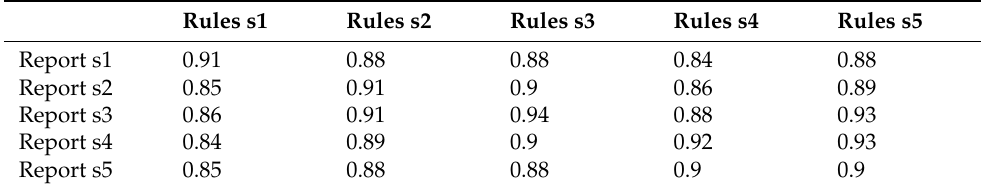
Figure 3. The framework of the experiment for cause identification. Table 9. Cross-validation of the cause identification